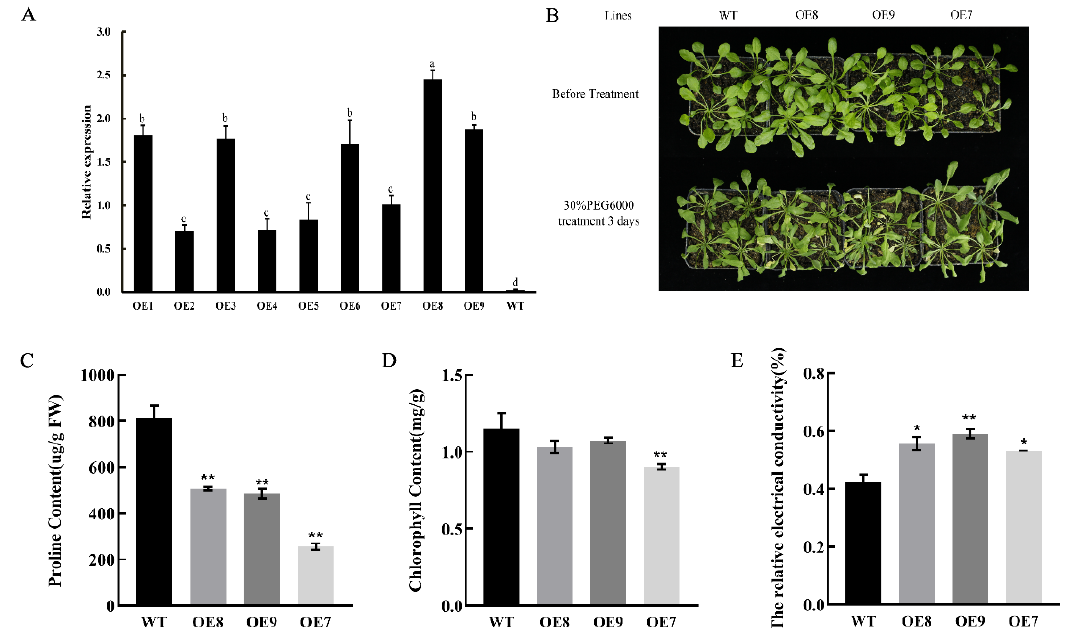
Figure 8. Heterologous overexpression of CpNAC1 negatively regulates tolerance to osmotic stress in transgenic Arabidopsis . ( A ) Relative expression of CpNAC1 in wild-type and transgenic Arabidopsis . Data represent means of three biological repeats ± standard deviations (SDs). Different lowercase letters indicate significant differences ( p < 0.05). ( B ) Phenotypes of wild-type and CpNAC1 transgenic Arabidopsis under 30% PEG6000 treatment. ( C – E ) Proline content, chlorophyll content, and relative electrical conductivity of wild-type and CpNAC1 transgenic Arabidopsis under 30% PEG6000 treatment. Data represent means of three biological repeats ± standard deviations (SDs). Asterisks denote statistically significant differences compared to controls, * p < 0.05, ** p < 0.01.